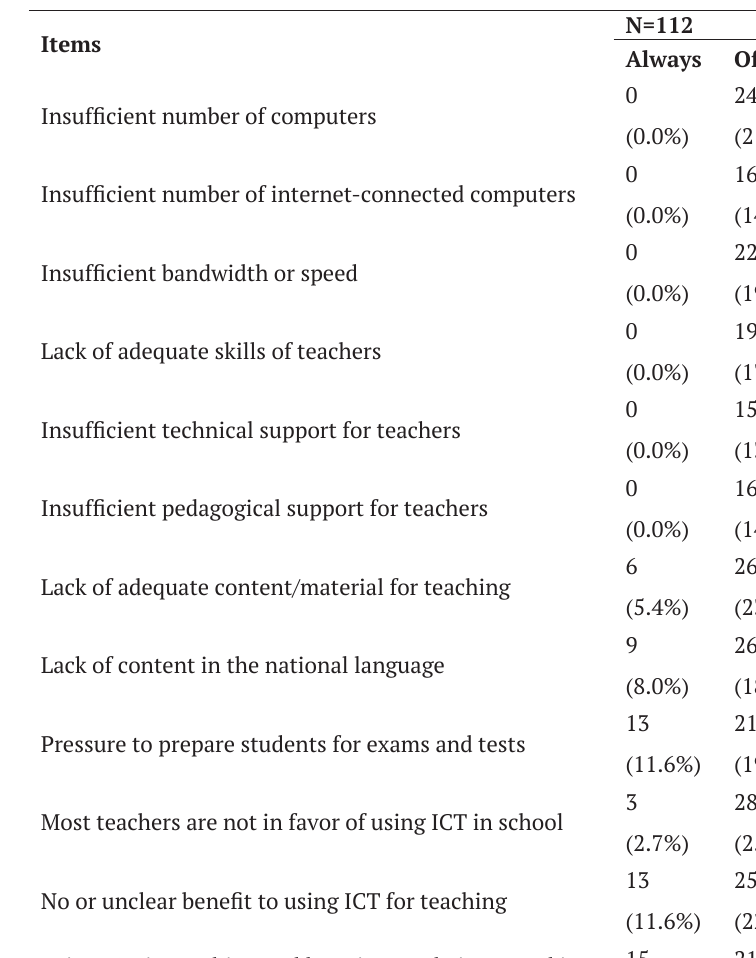
Table 1. Challenges in using ICT tools in PE Teaching & Learning Items